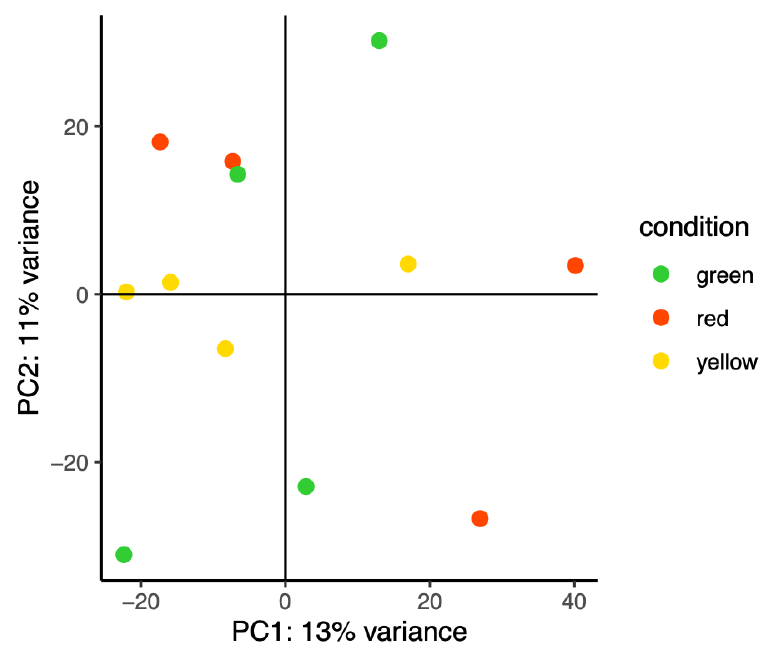
Figure 2. Principal component analysis (PCA) of genome-wide gene expression based on the negative binomial distribution of gene expression for all phenotypes. Each green, red or yellow dots represent an individual of the corresponding color.